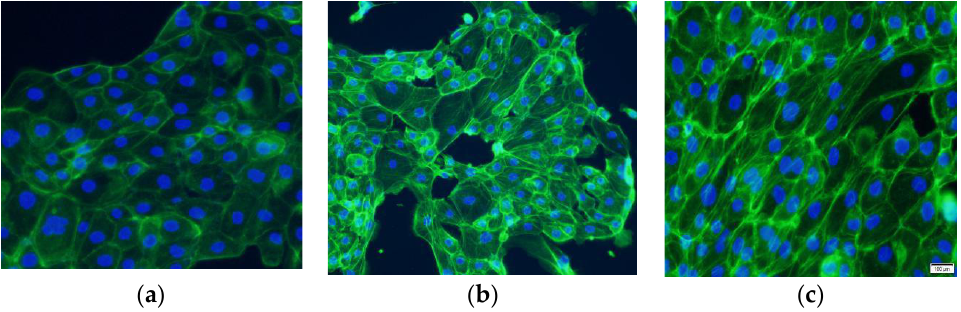
Figure 2. Fluorescence staining of the actin cytoskeleton of IPEC-J2 cells with phalloidine. ( a ) Con- trol group: F-actin was equably distributed; ( b ) TGEV group: F-actin was distributed in bundle; ( c ) TGF- β group: the result was similar to the TGEV group.